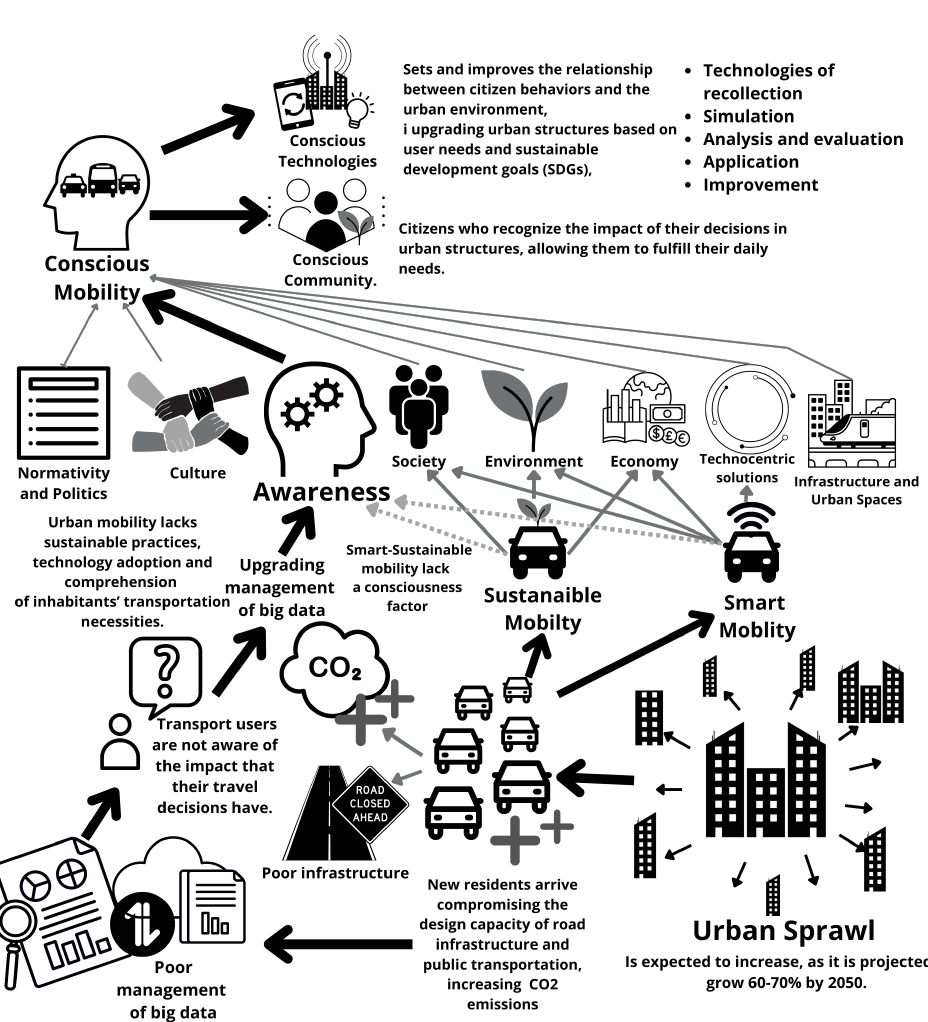
Figure 2. Soft methodology scheme of conscious